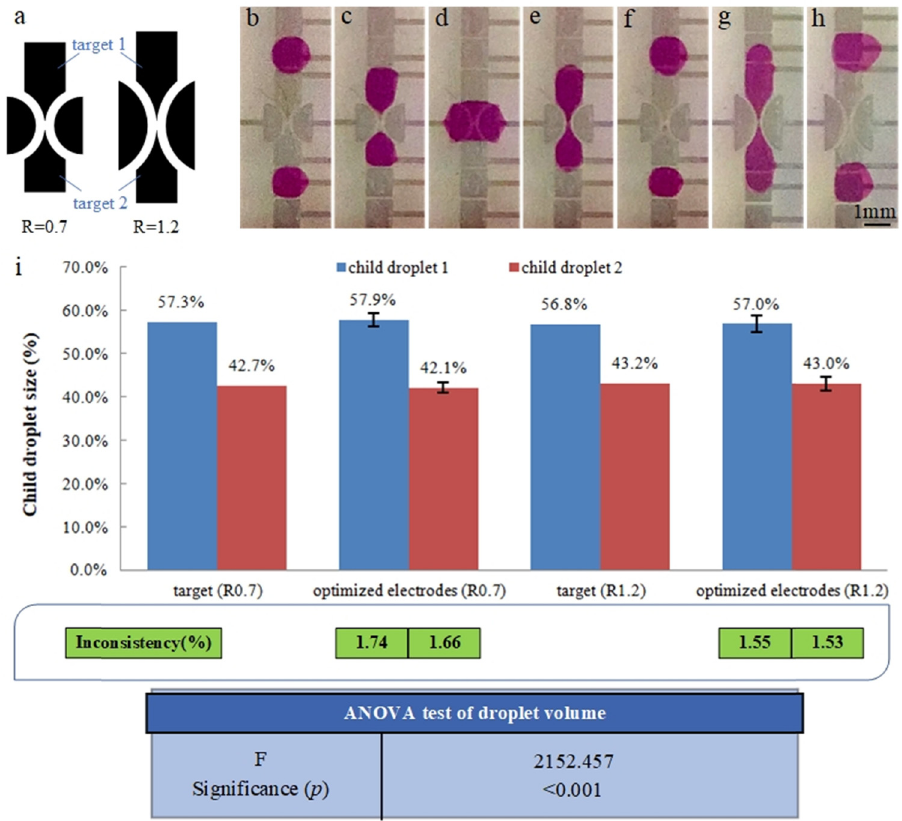
Figure 11: Droplet splitting with unequal volume using the optimized electrodes scheme; ( a ) Two types of optimized electrodes in which the cutting electrode radius was 0.7 and 1.2 mm, respectively; ( b – f ) Series of video frames displaying unequal splitting using the cutting electrode with a radius of 0.7 mm; ( g and h ) Series of video frames displaying unequal splitting using a cutting electrode with a radius of 1.2 mm; ( i ) The volume of the child droplets for two optimized splitting electrodes. The child droplet 1 and 2 correspond to the droplet split on target electrode 1 and 2,